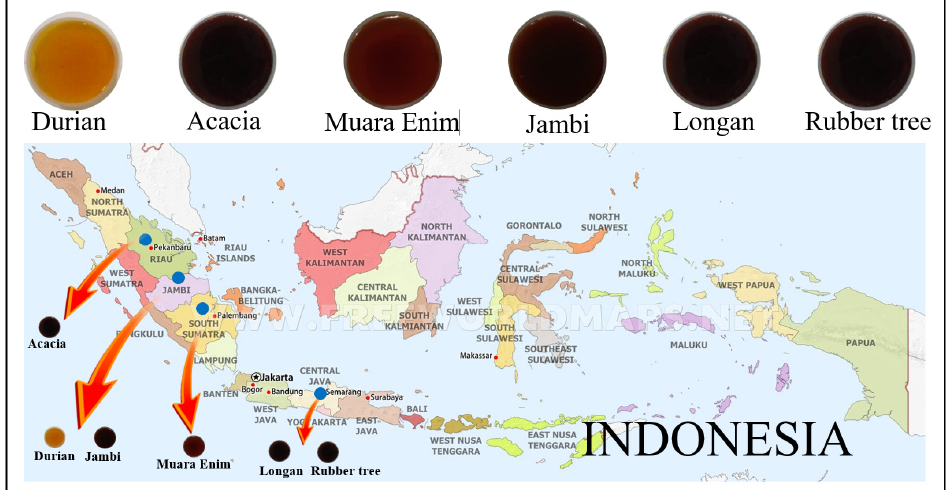
Figure 1. Geographical origin of Indonesian honeys used in this study.